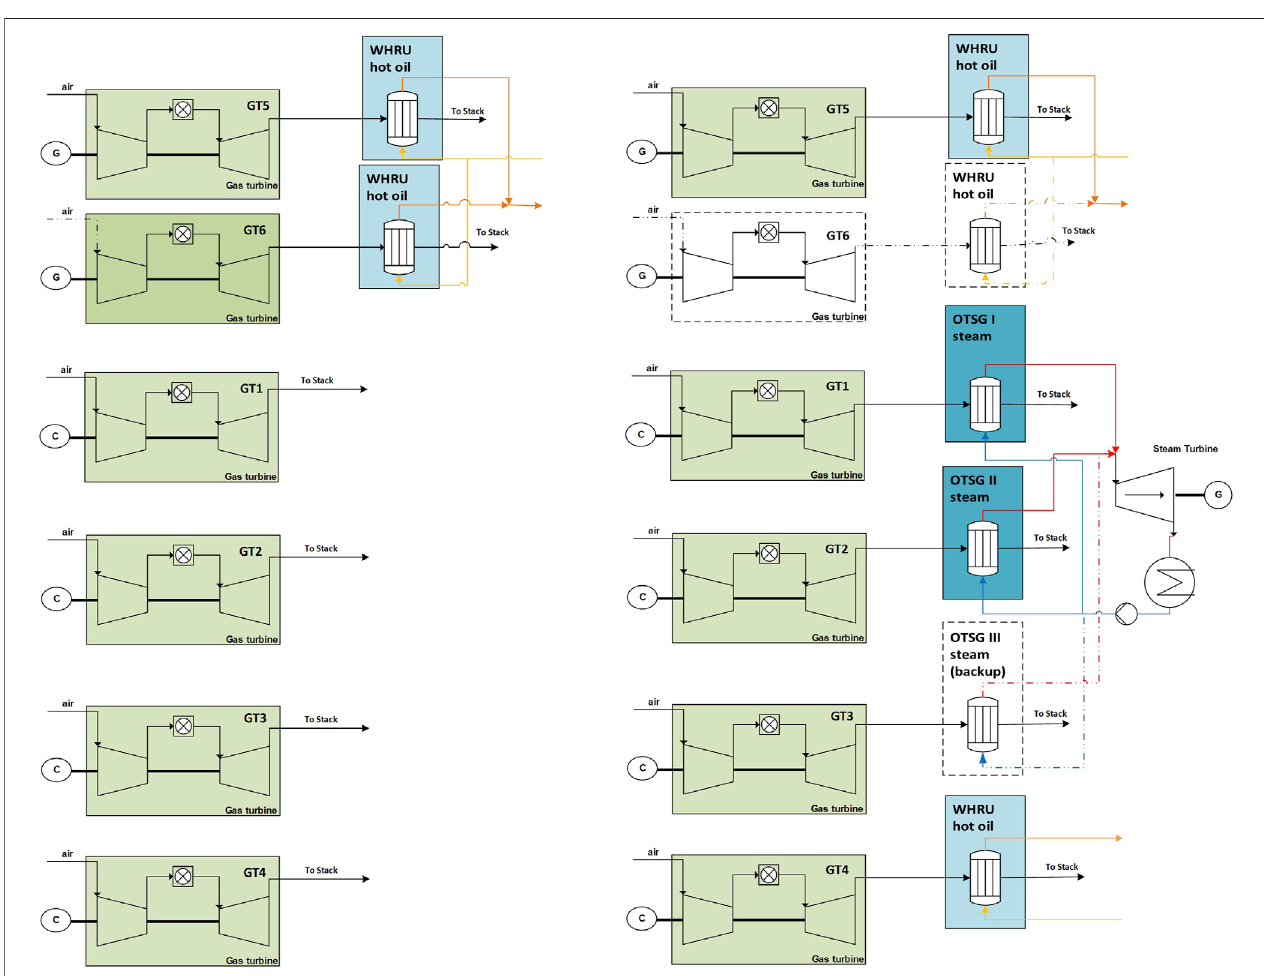
FIGURE 2 | Reference system (A) and proposed retro fi tted system (B) for heat and power (mechanical and electric) generation system based on GTs at the off-shore platform.